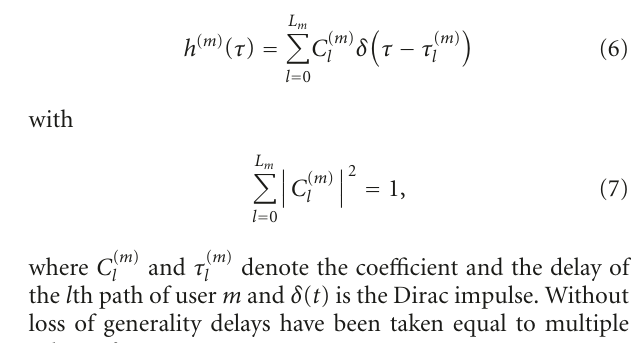
changing the dynamical properties of the map. Mean values of all sequences are assumed equal to zero ( μ = 0) in this paper. The spreading factor β is equal to the number of chaotic samples in a symbol duration ( β = T s /T c